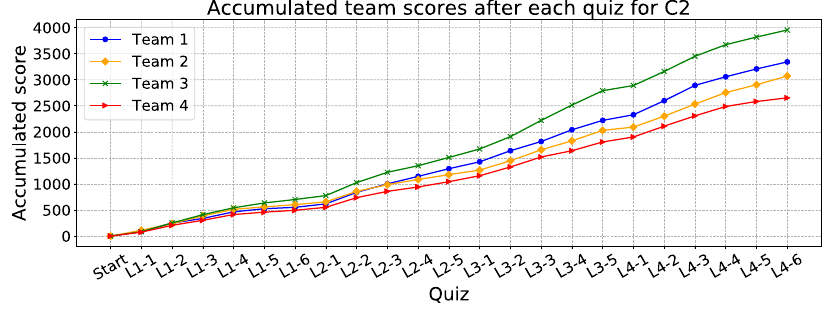
Fig. 4. Development of the accumulated team scores after each quiz for C2.